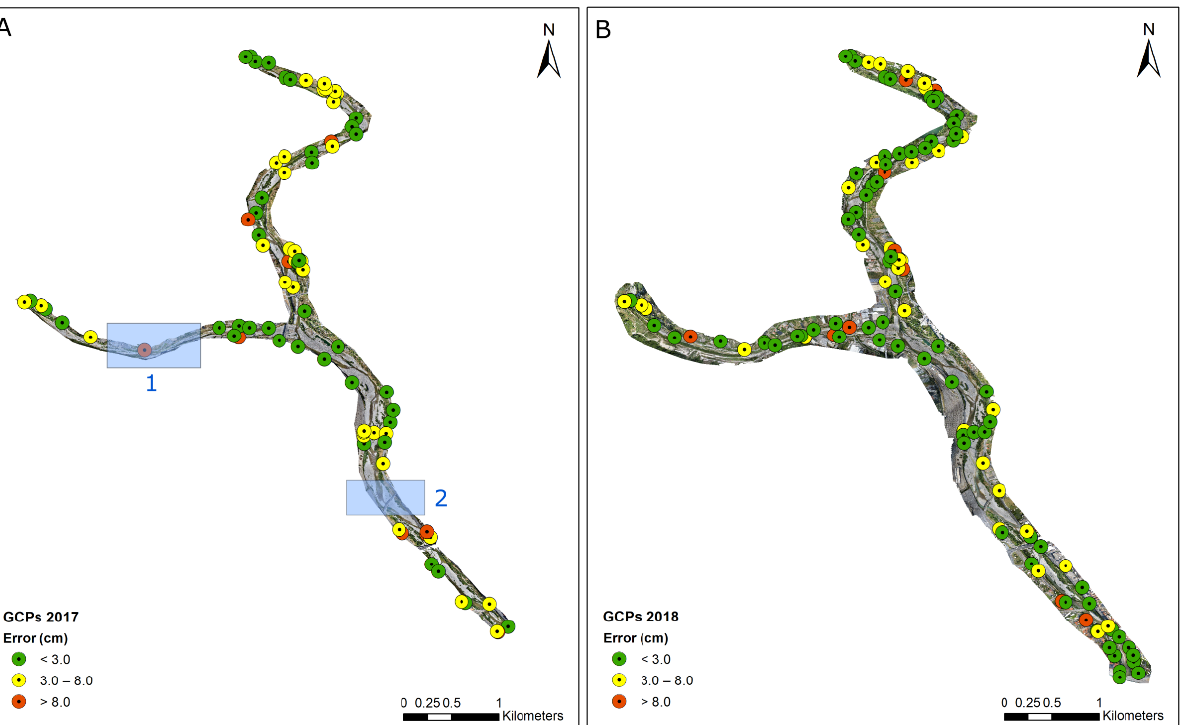
Figure 7. Distribution of the GCPs: location and error. ( A ) UAV survey carried out in 2017; 1 and 2 highlights areas with low concentration of GCPs. ( B ) UAV survey carried out in 2018.